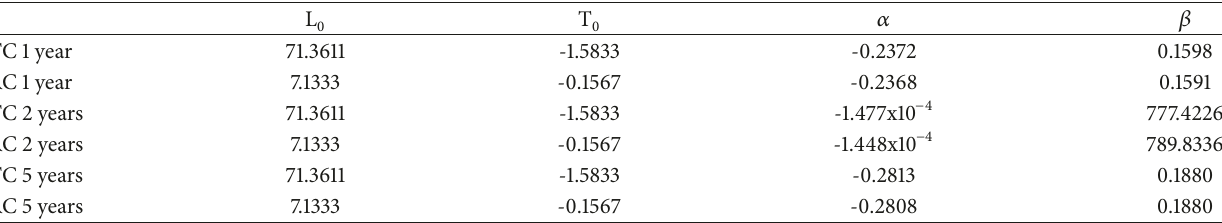
Table 12: LES Model Optimised Parameters.